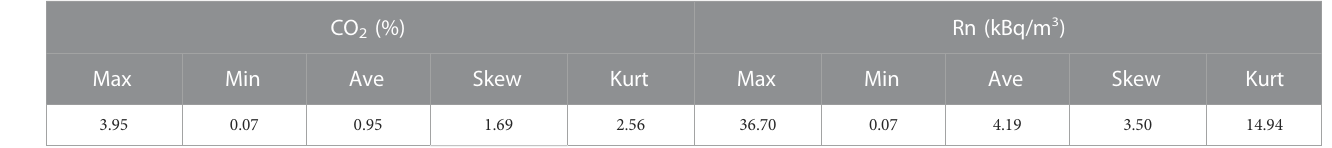
TABLE 1 Statistics of soil gas Rn and CO 2 in gridded observation